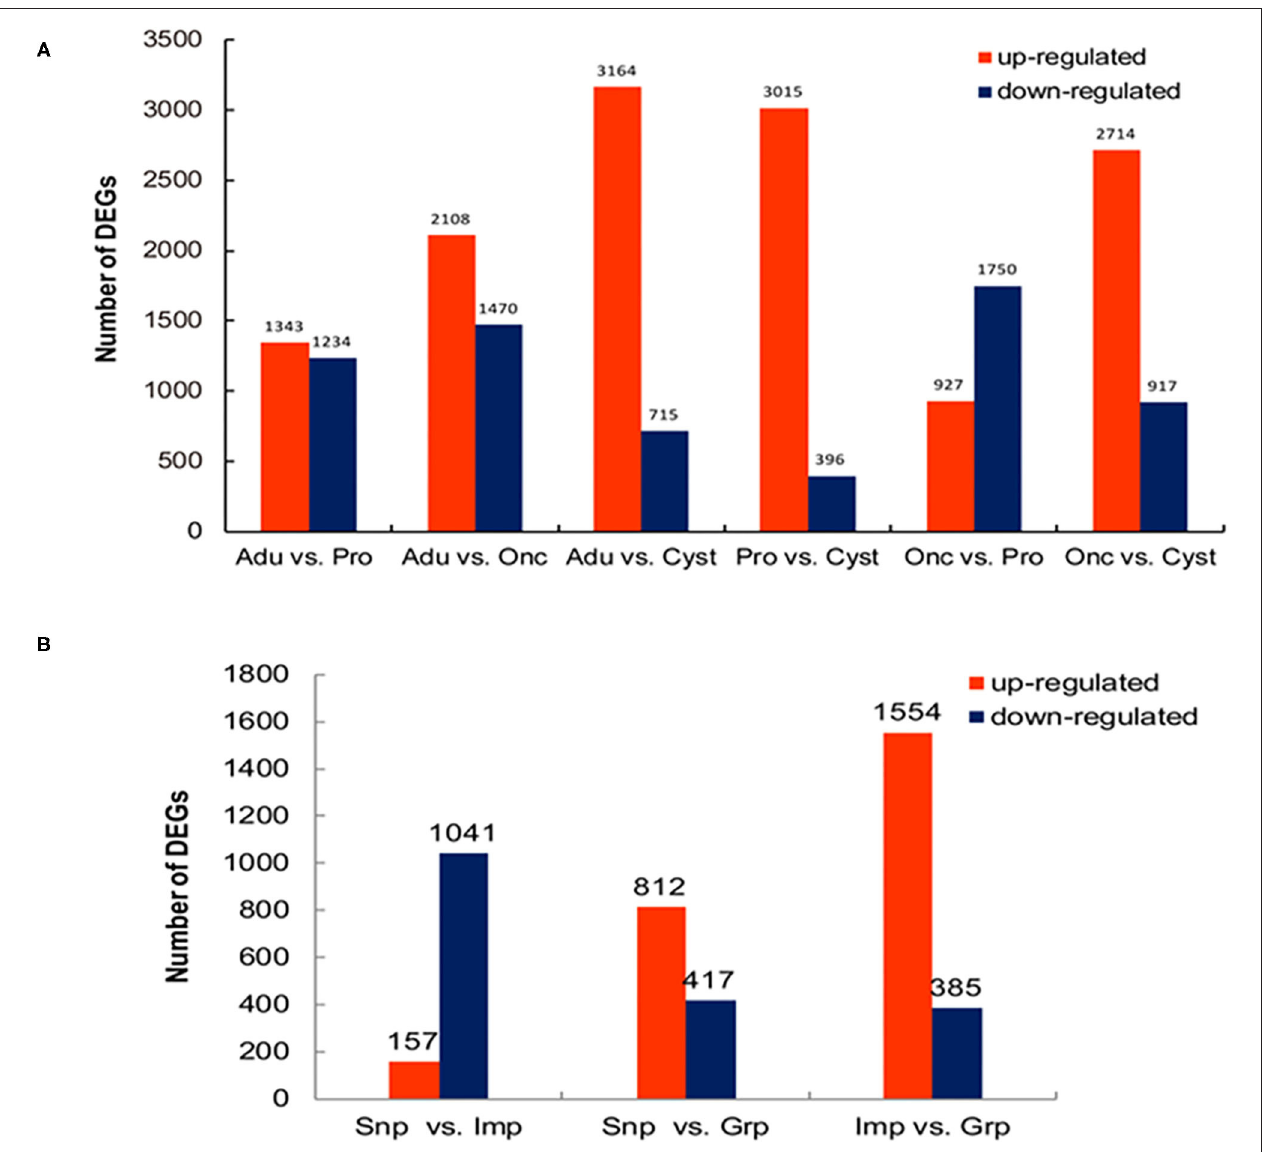
FIGURE 1 | Differentially expressed genes (DEGs) among the developmental stages and tissues of adult T. multiceps. (A) Numbers of DEGs in the different stages. (B) Numbers of DEGs in the different adult